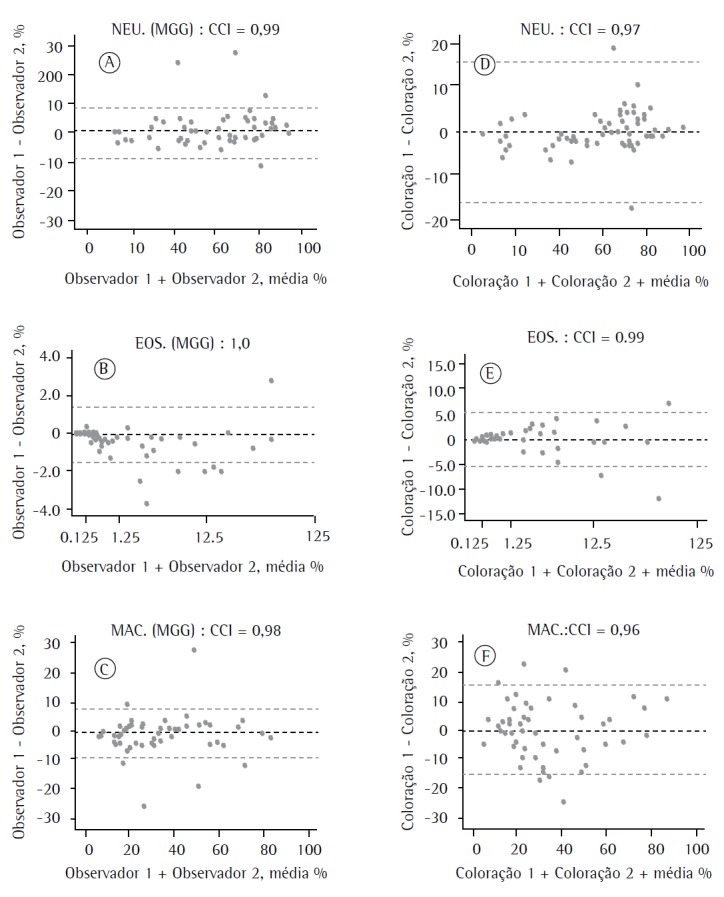
 Representações gráficas de Bland & Altman. Reprodutibilidade
interobservador das proporções de neutrófilos (em A), eosinófilos (em B) e
macrófagos (em C) no escarro induzido em lâminas coradas por
May-Grünwald-Giemsa (MGG). Reprodutibilidade intraobservador das proporções
de neutrófilos (em D), eosinófilos (em E) e macrófagos (em F) no escarro
induzido em lâminas coradas pelos dois métodos de coloração. As
representações se referem às diferenças entre as leituras dos observadores 1
e 2 (eixo y) em relação à média das leituras dos observadores 1 e 2 (eixo
x). A linha interrompida central indica ausência de diferenças e as linhas
interrompidas periféricas indicam dois desvios-padrão da média das
diferenças. CCI: coeficiente de correlação intraclasse; NEU.: neutrófilos;
EOS.: eosinófilos; e MAC.: macrófagos.